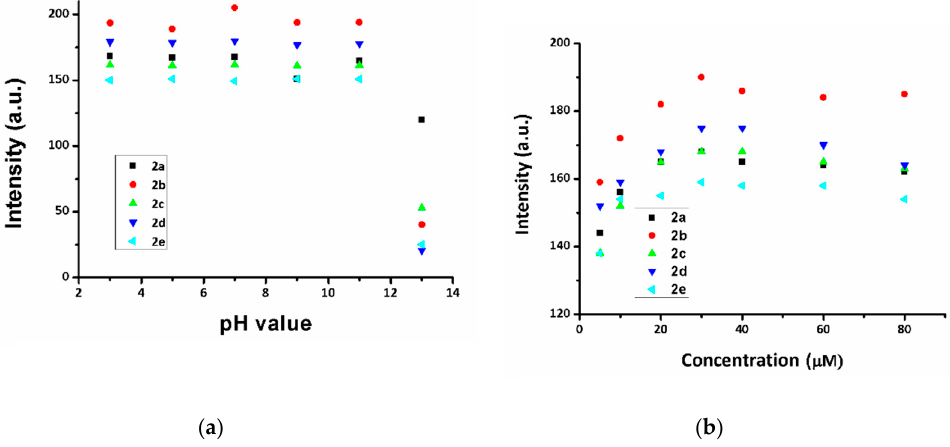
Figure 1. Fluorescence emission intensities of 2a – e ( λ ex according to Table 1) ( a ) at various pH values and ( b ) at various dissolved coumarin concentrations in DMSO/HEPES buffer ( v / v , 1/9).